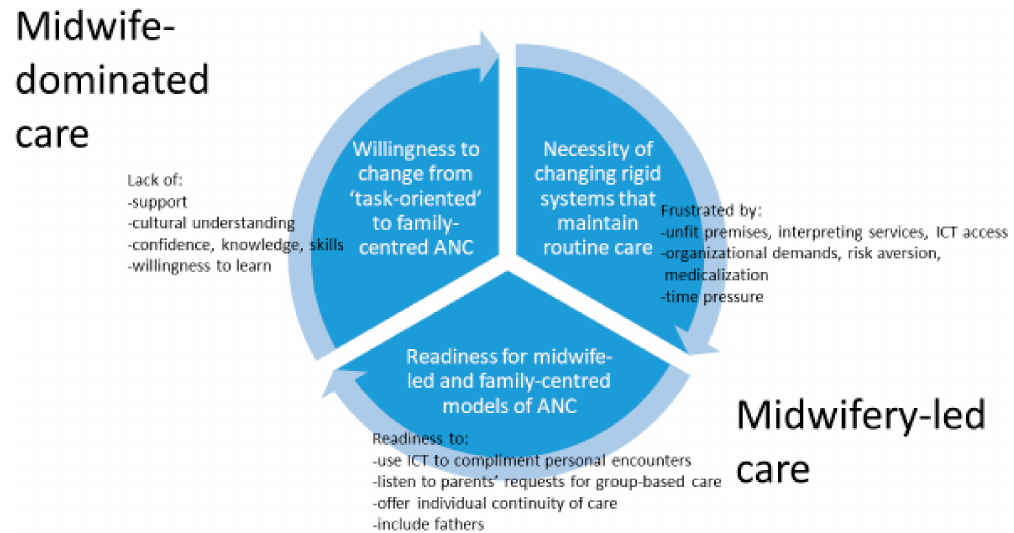
Figure 2. Antenatal care, from a midwife-dominated toward a midwifery-led